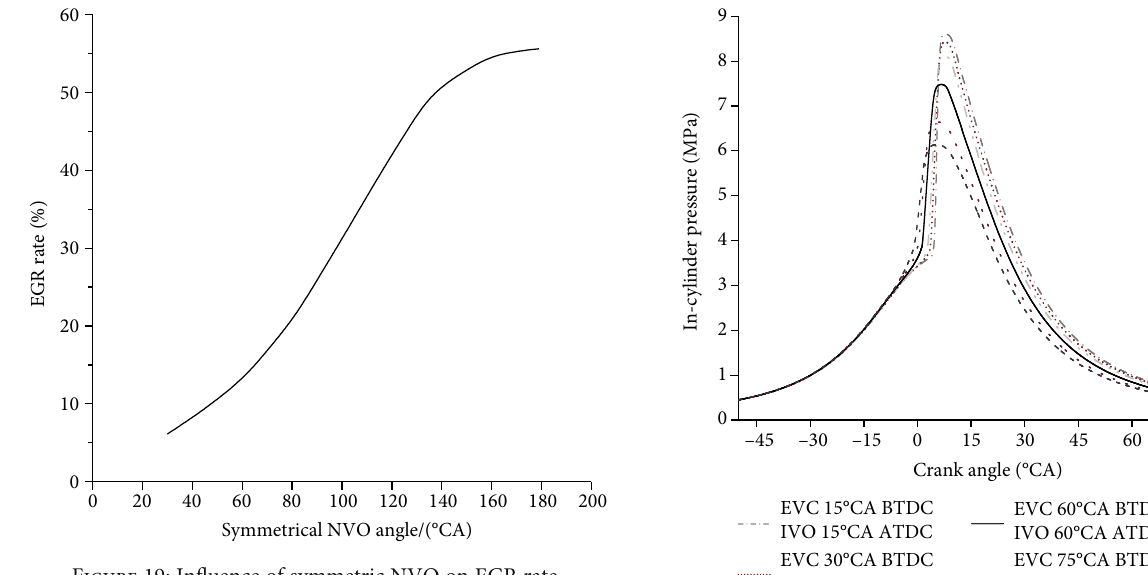
Figure 19: In fl uence of symmetric NVO on EGR rate.